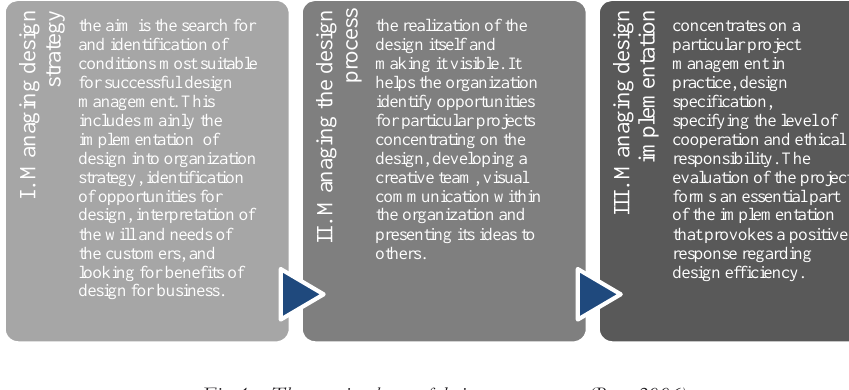
Fig. 1 – Three main phases of design management (Best,